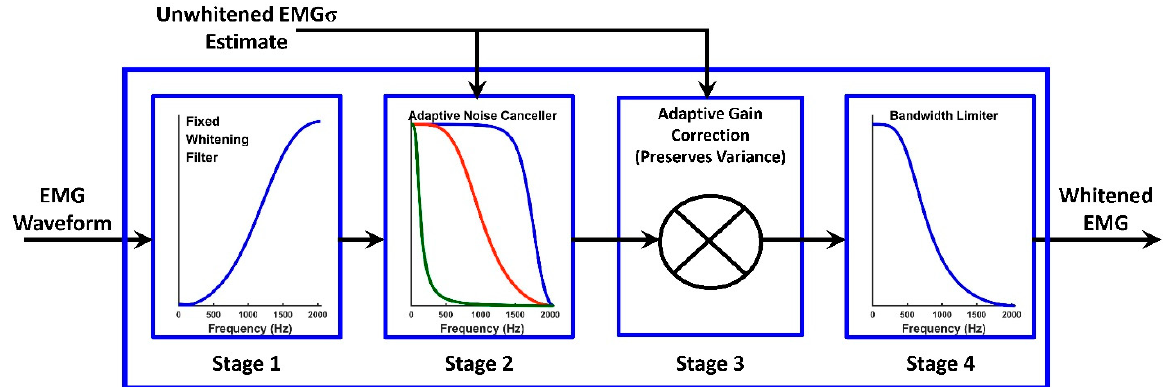
Figure 3. Four-stage whitening filter [27,36]. Stage 1 is a fixed linear filter that whitens the true EMG signal. Stage 2 is an adaptive linear low-pass filter (formally a Wiener filter) that progressively rejects more of the higher frequencies as the effort level decreases. Stage 3 is an adaptive gain that preserves the variance of the true EMG through the first three stages. Stage 4 is a high-order, fixed low-pass filter that limits whitening bandwidth.